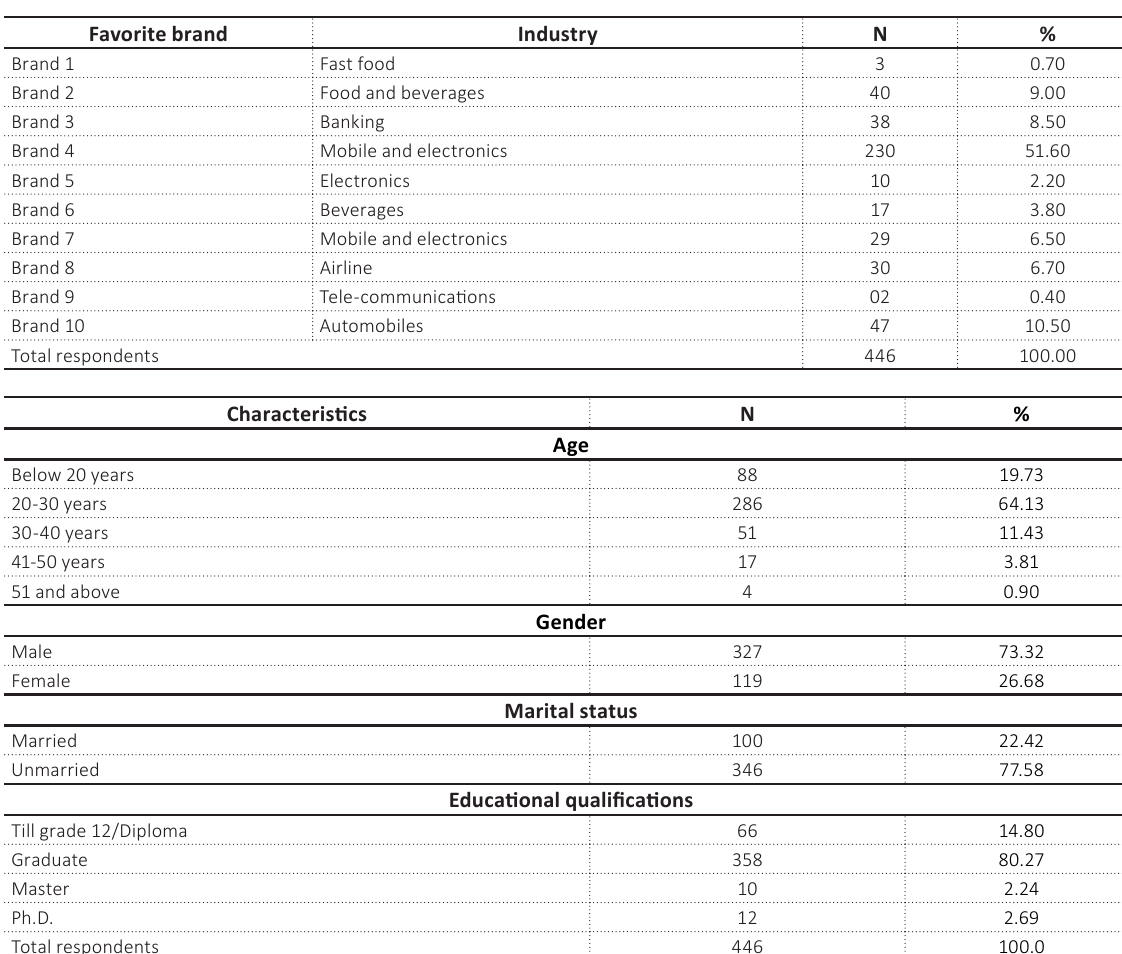
Table 1. Demographic profiles and data